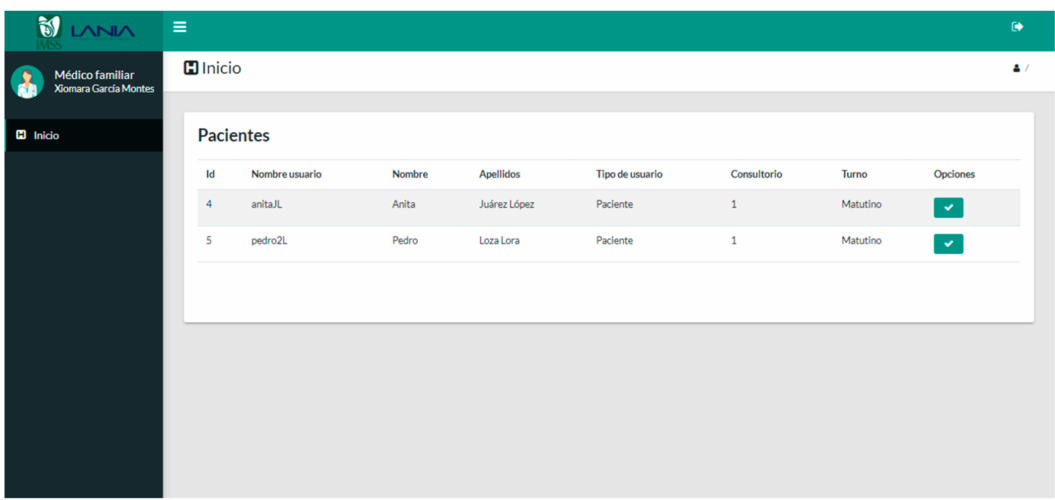
Figure 14. Physician application interface: Physician’s main menu with the list of assigned